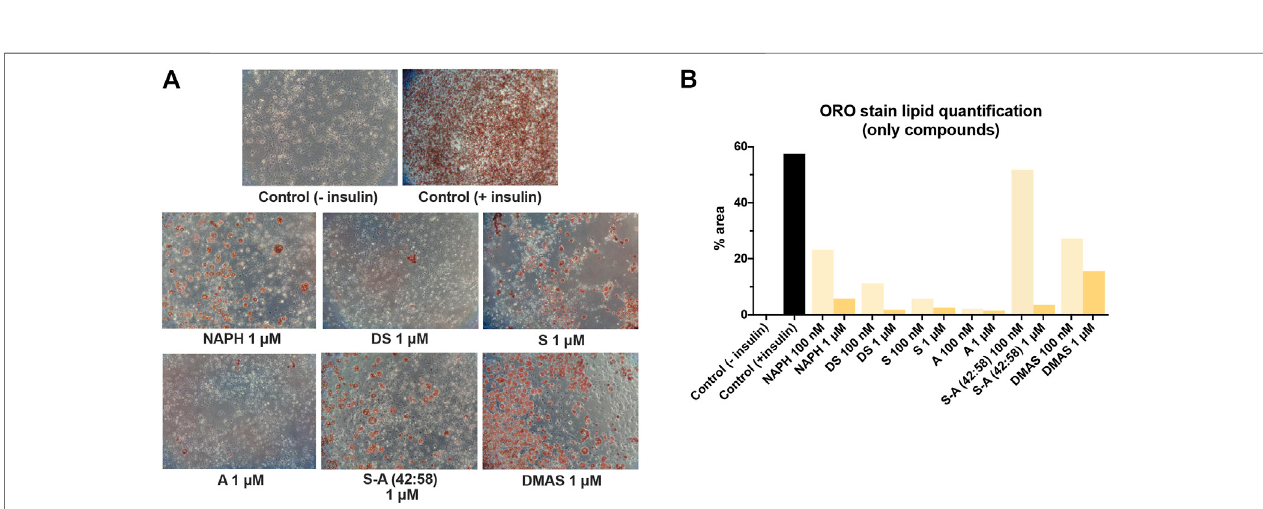
FIGURE5| Differentiationof3T3-L1cellsinthepresenceonlyofA/Sderivatives. (A) Representativemicroscopicimagesofthestainedcellsforthevarioussamples at 1 μ M. Control ( − insulin) and control (+insulin) represent negative and positive control samples, respectively. All images were recorded at ×10 magni fi cation. (B) Lipid quanti fi cation based on the amount of ORO stain present in each